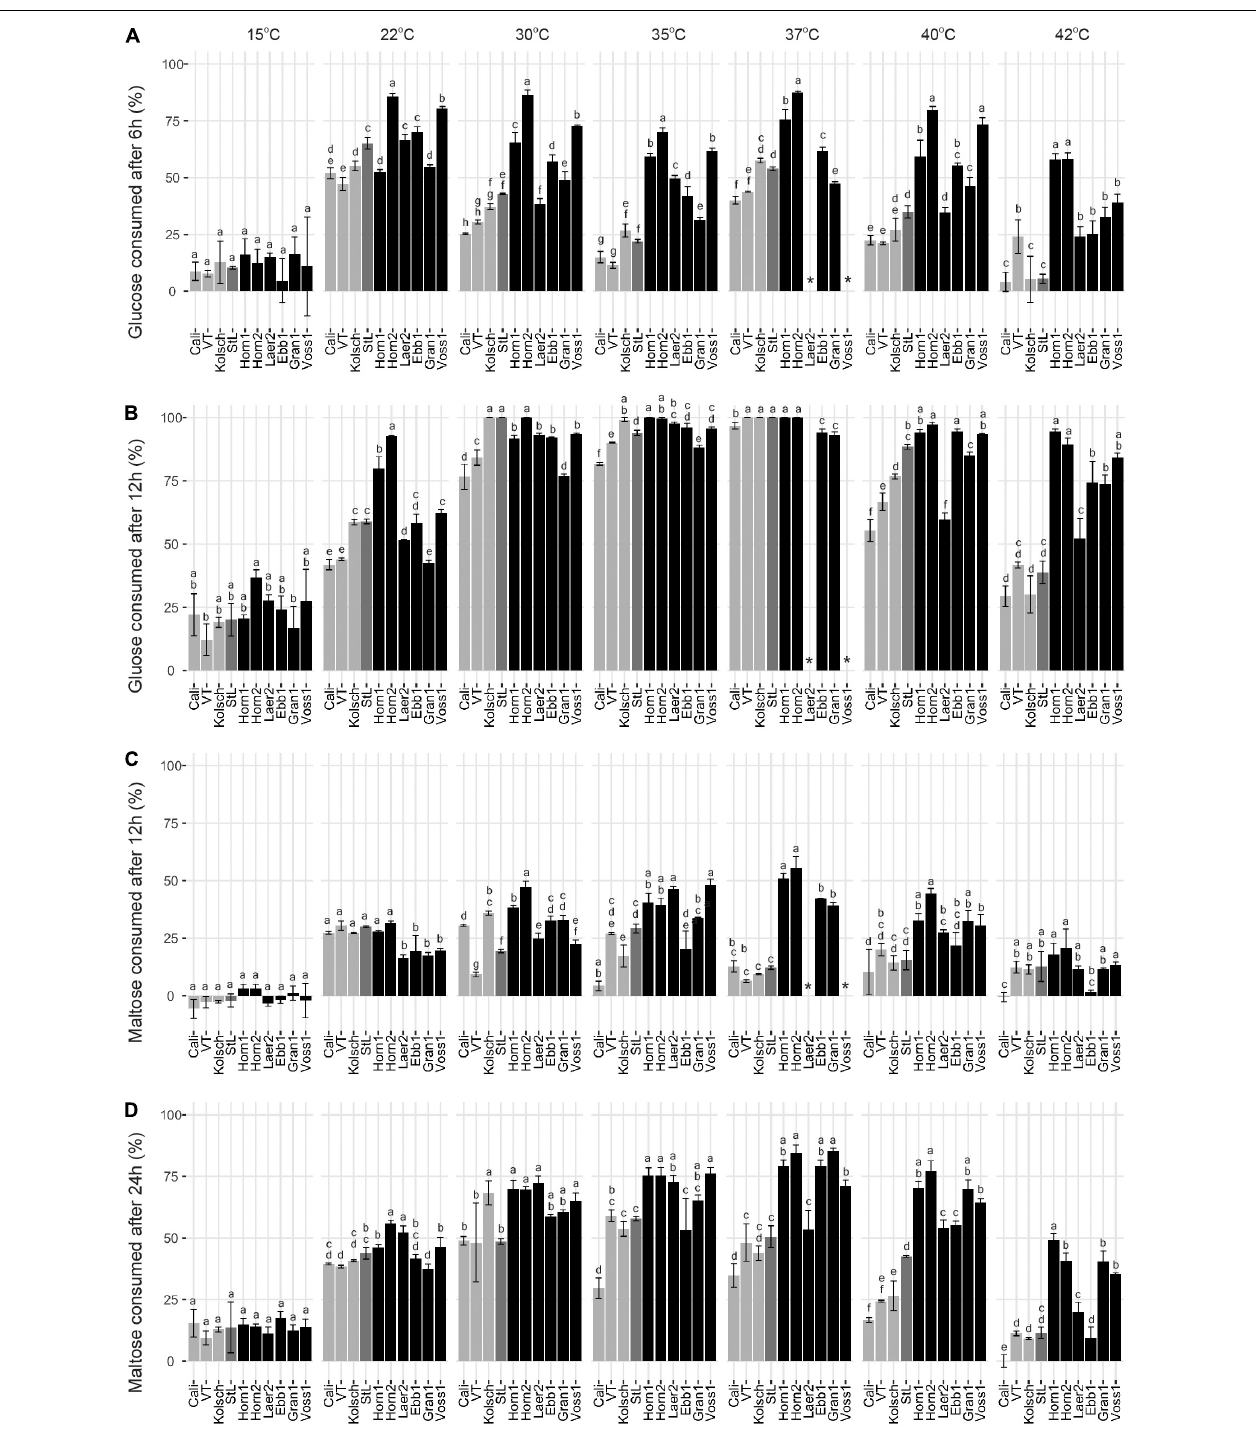
FIGURE 5 | Comparison of the early glucose and maltose consumptions of four commercial Saccharomyces cerevisiae ale strains and six Norwegian kveik isolates at each of the indicated temperatures between 15 and 42 ◦ C. Samples were collected for HPLC analyses at the same timepoints of SG measurements in Figure 2 . The percentage (%) of total sugar consumed post-inoculation are presented for glucose after (A) 6 h and (B) 12 h, and for maltose after (C) 12 h and (D) 24 h. Data points represent the mean of biological replicates ( n = 3) and error bars represent the standard deviation. Data was subjected to one-way ANOVA followed by Tukey’s HSD analysis of the mean sugar consumption between strains for each timepoint and temperature (Concentration ∼ Strain). Mean values assigned with a common letter are not significantly different by the HSD-test at the 5% level of significance within the same temperature. Light gray bars are Beer 1, dark gray bars are Beer 2, and black bars are kveik